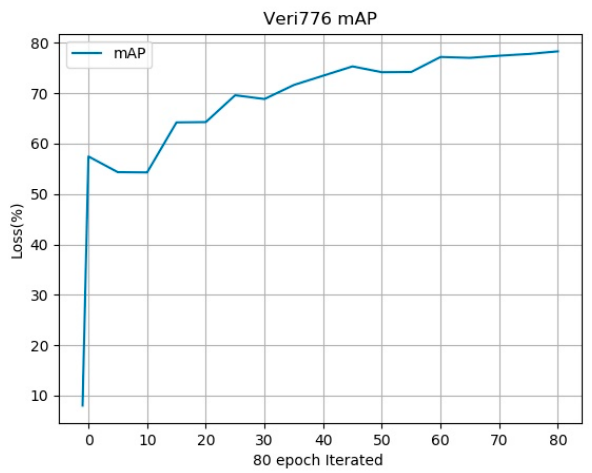
Figure 8. VeRi -776 mAP curve. Figure 8. VeRi-776 mAP